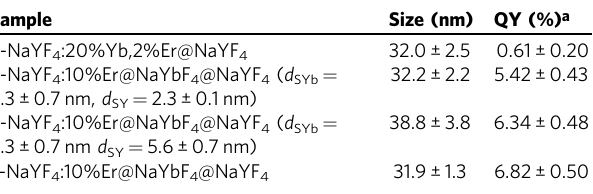
Table 1 Upconversion quantum yields of Er 3 + -doped UCNPs synthesized in this